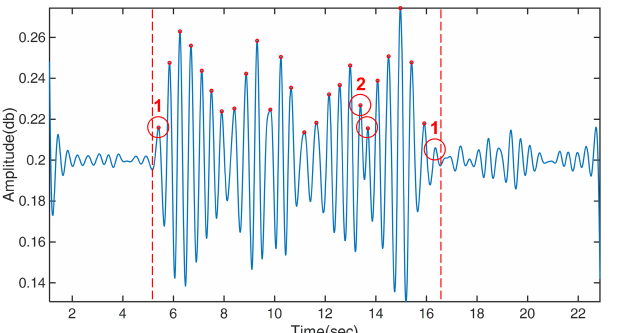
Figure 15. Illustration of packet loss (red Type 1 circles) and overestimation of the motion duration (red Type 2 circle).